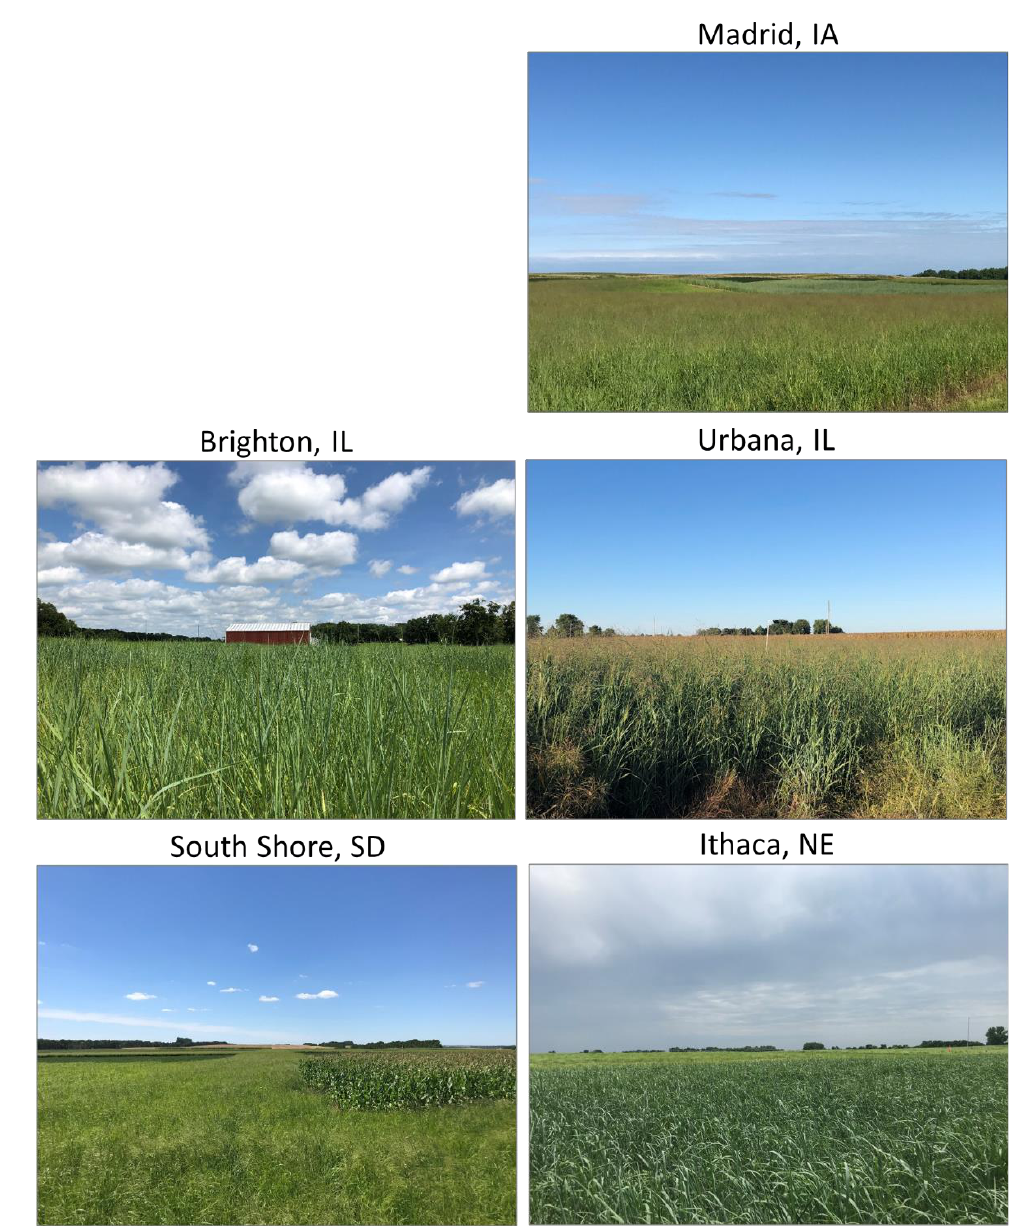
Figure 2. Photos of the study sites. The Brighton, Illinois (IL), and Urbana, IL, sites show ‘Independence’ switchgrass (SW) from July 2020 and September 2020, respectively. The Madrid, Iowa (IA), site shows ‘Shawnee’ SW foreground, Independence SW in the middle, and ‘Liberty’ SW in the top right before the tree line (July 2020). The Ithaca, Nebraska (NE), site shows Independence SW in the foreground and a low diversity mixture in the background (June 2020). The South Shore, South Dakota (SD), site shows ‘Sunburst’ SW as a border, corn on the left, and ‘Carthage’ SW and a soybean on the right (July 2020).